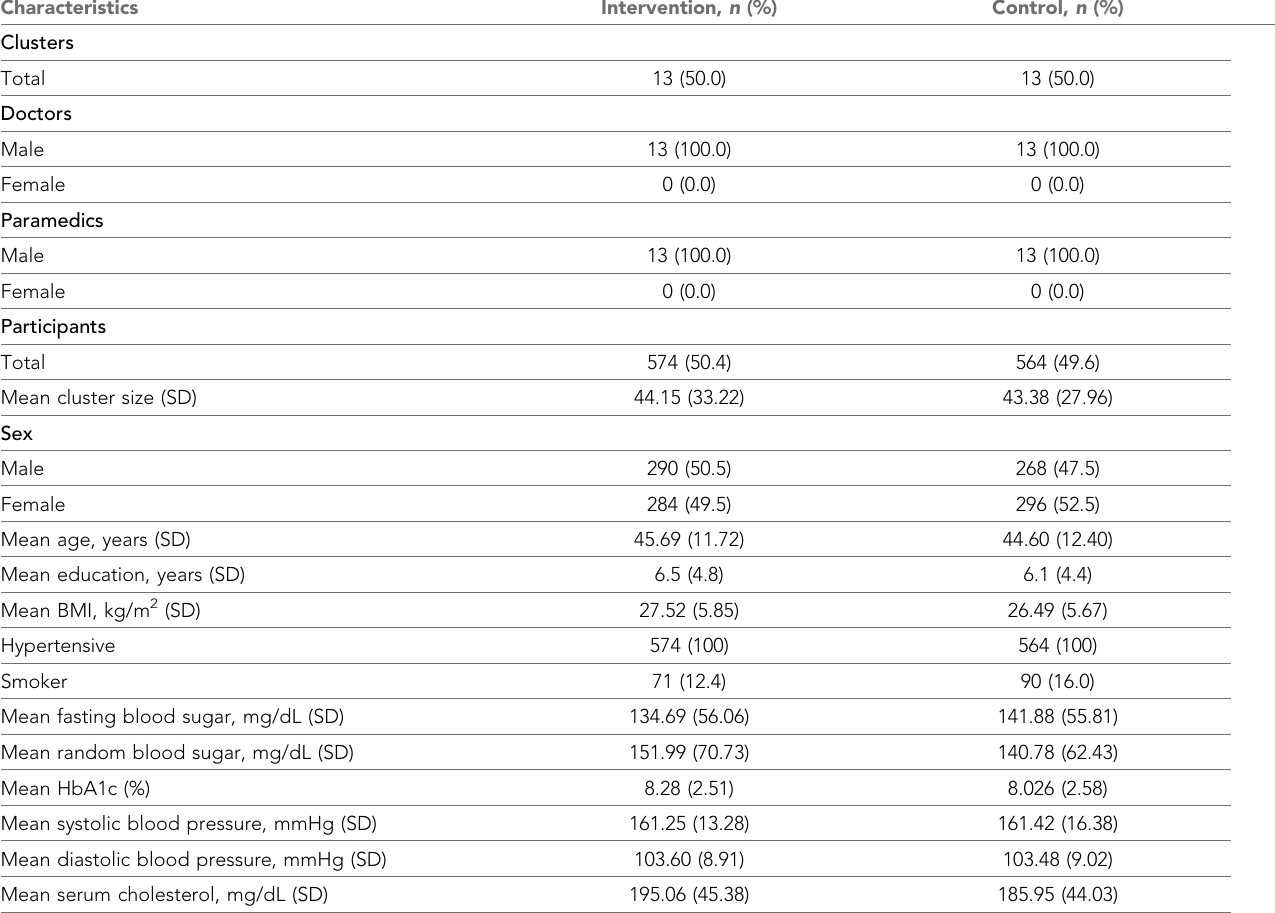
Table 1. Baseline characteristics